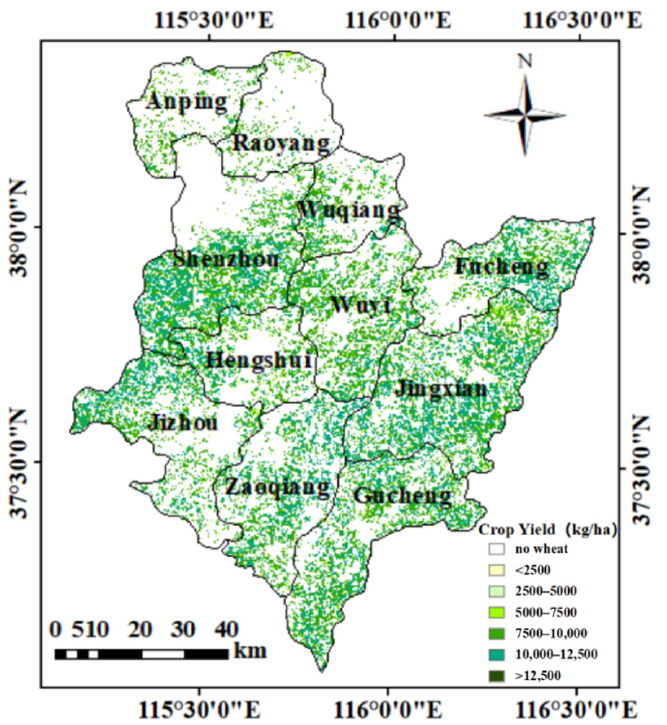
Figure 11. Predicted regional winter wheat yields in Hengshui City using the BHT-ARIMA model.